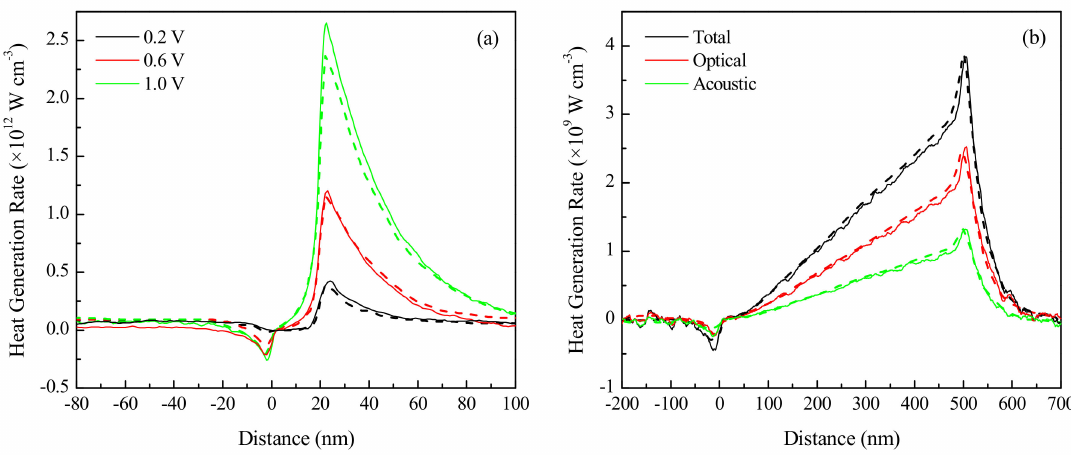
Figure 3. Volumetric heat generation rates at 300 K over the lengths of ( a ) 20 nm and ( b ) 500 nm channel n + nn + devices. Solid lines are the results of this work, and dashed lines are the Monte Carlo (MC) results obtained from Pop et al.